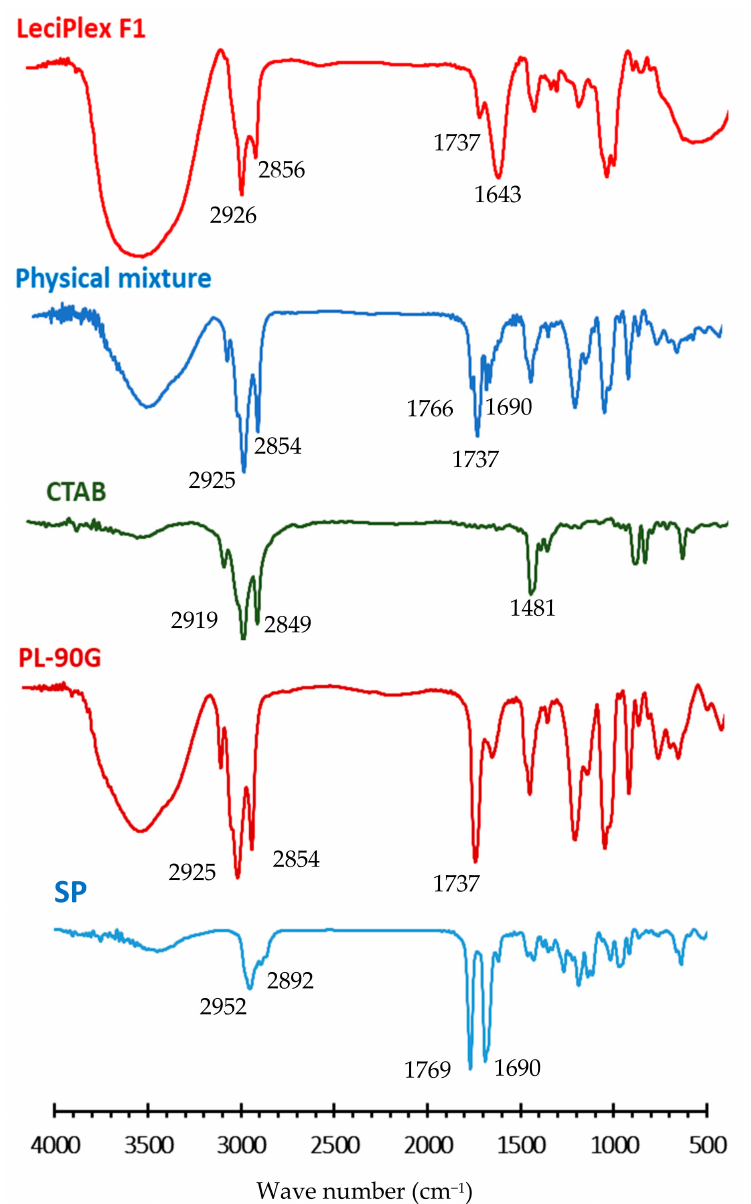
Figure 1. FT-IR spectra of spironolactone (SP), Phospholipon ® 90G (PL-90G), cetyltrimethylammonium bromide (CTAB), their physical mixture, and LeciPlex formulation